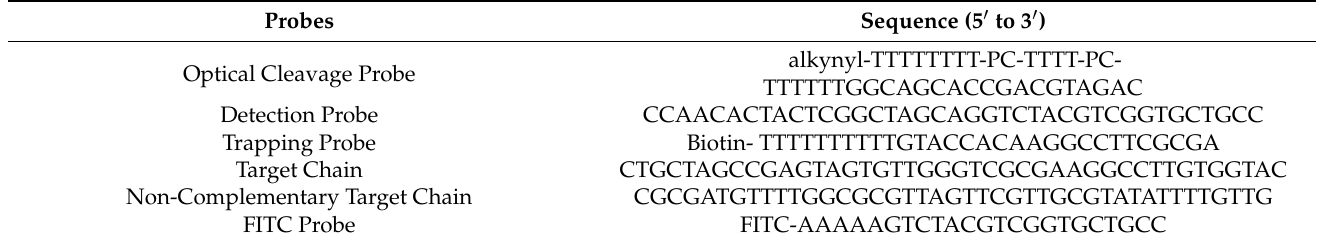
Table 1. Synthetic oligonucleotide sequences.